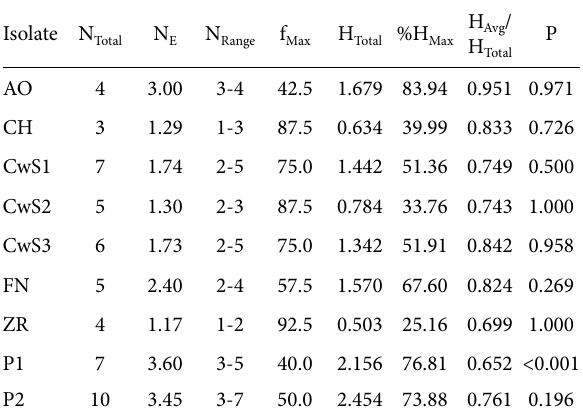
Table 1. Genomic variant diversity of nine Citrus tristeza virus iso- lates, based on SSCP